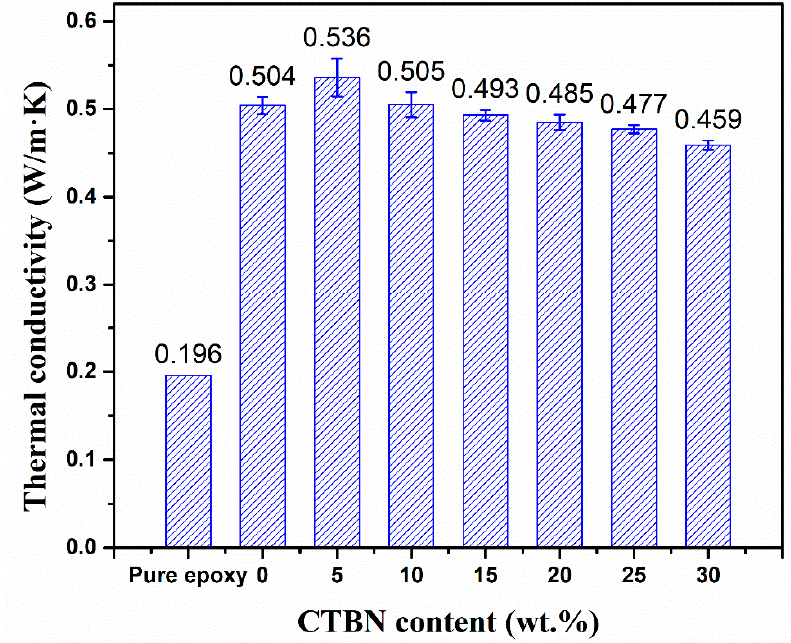
Figure 5. Thermal conductivity of composites with different CTBN contents.